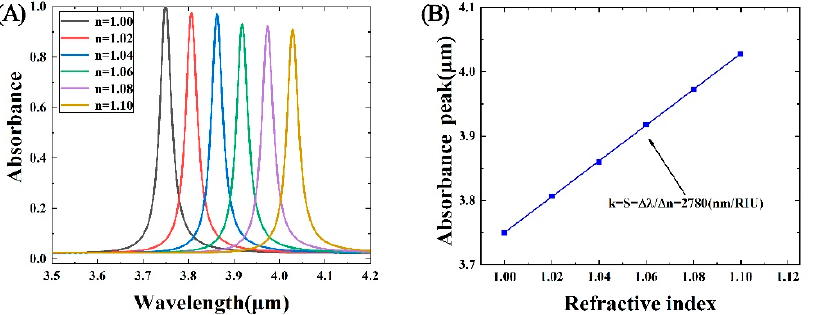
Figure 8. ( A ) Absorbance spectrogram and ( B ) relationship between RI and the corresponding peak wavelength of symmetrical Si grating under RI change. K and S represent the slope of the straight line and the sensitivity of the structure,